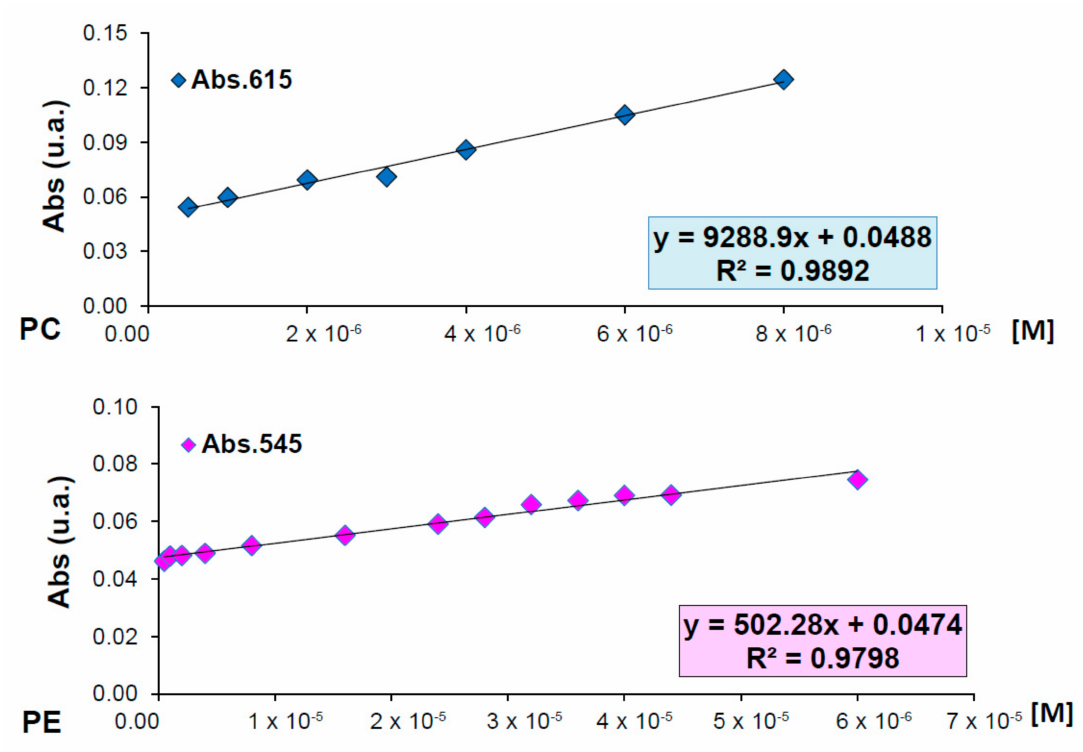
Figure 3. Calibration lines from dyes PC ( λ 615 nm) and PE ( λ 545 nm) in water dilutions from the initial buffer phosphate concentration.